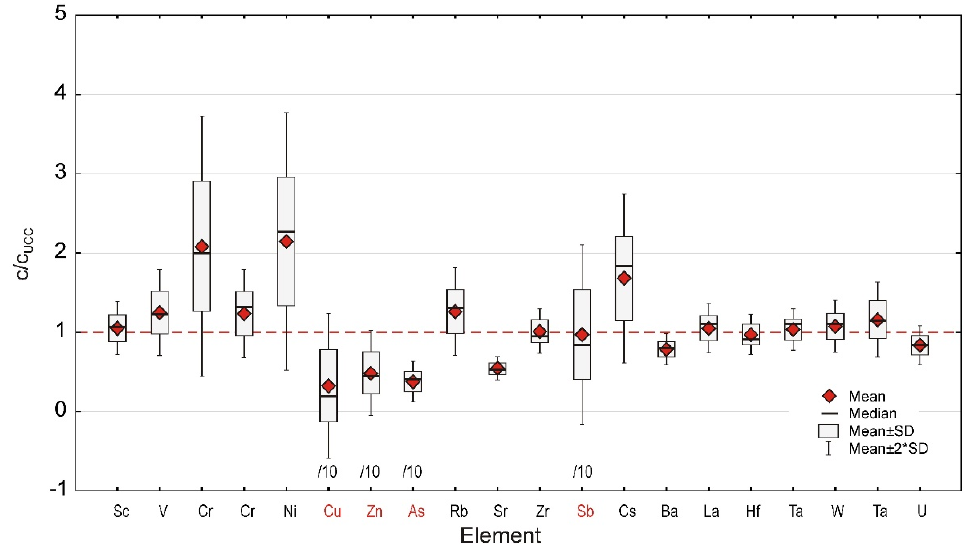
Figure 4. Box and whiskers diagrams illustrate the mass fraction distribution of trace elements in the investigated sediments, with all mass fractions being normalized to the UCC [22] values. As the mass fractions of PCE Cu, Zn, As, and Sb significantly exceeded the UCC values, the corresponding ratios were reduced ten times.